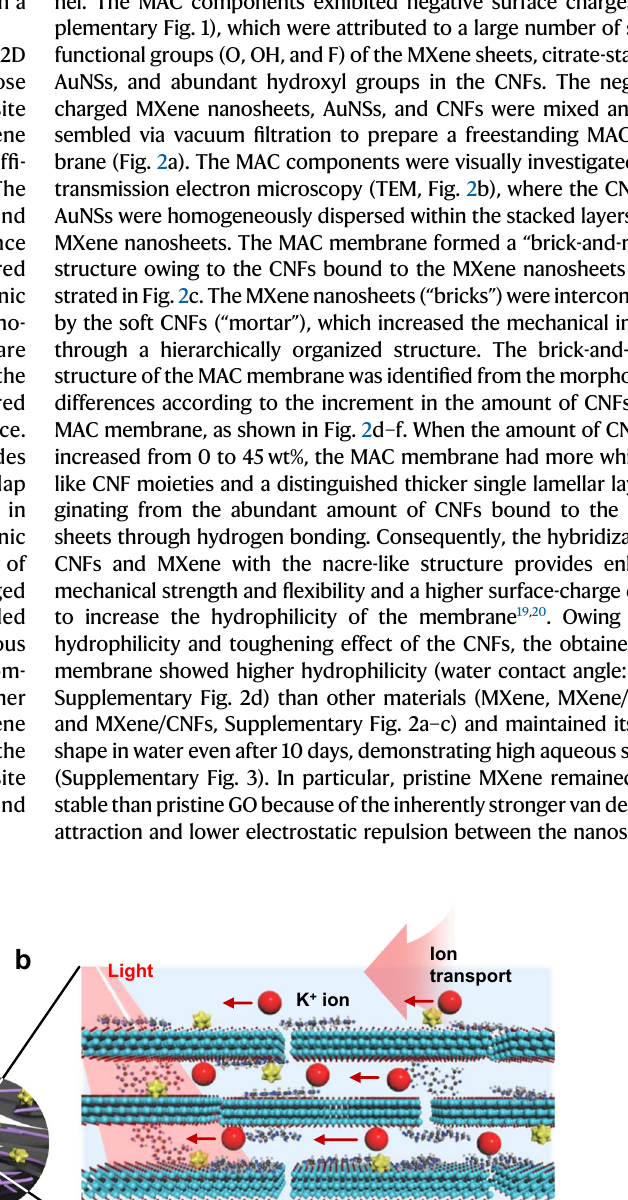
cationtransportthroughtheMACmembraneunderphotothermalgradient,which is driven by the interfacial photothermo-osmotic fl ow. c Schematic description of MAC components including MXene, AuNS, and